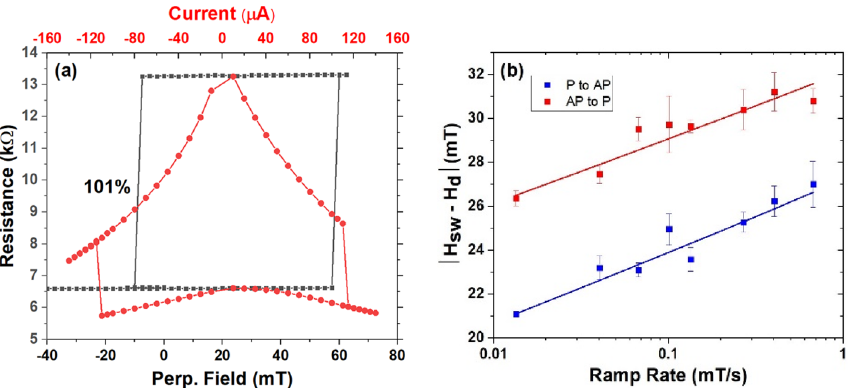
Figure 4. ( a ) The TMR curve of the 145 nm-diameter MTJ nanopillar with 101% TMR ratio (black squares) and the current-induced resistance switching (red dots) by the STT effect. ( b ) The ramp-rate-dependent switching field measurements for both P-to-AP and AP-to-P